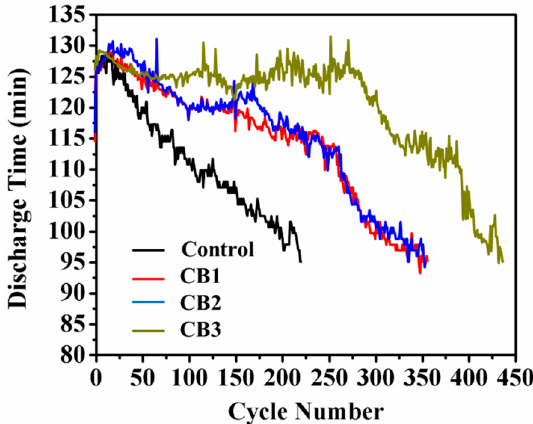
Figure 5. Effect of carbon black on the cycle life of VRLA (48 V/12 Ah) batteries under 100% depth-of-discharge (DoD) conditions at C 2 discharge rate (6 A). Plots of the discharge time and the number of cycles for three different specific surface areas (SSAs) of carbon black are used as negative additives for lead–acid batteries and acetylene black as a control additive.